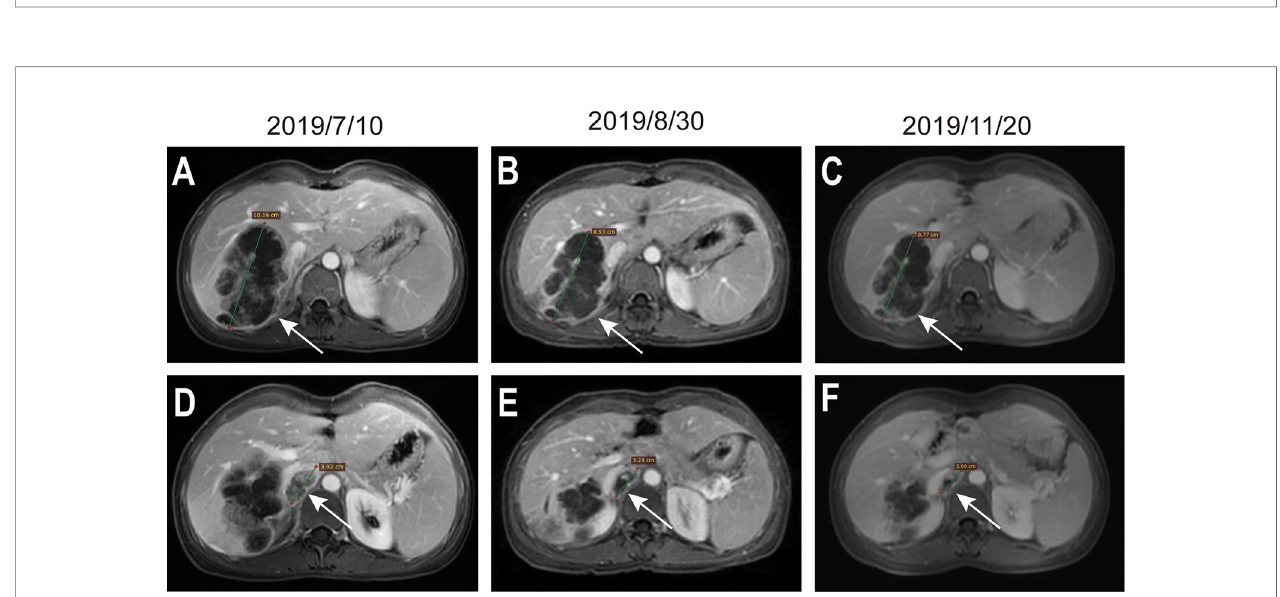
FIGURE 3 | MRI evaluation during preoperative systemic treatment. (A – C) indicate the maximum diameter of the lesion located in the liver, the maximum diameter of the lesion in (A – C) were 10.16cm, 8.93cm, and 8.77cm. (D – F) indicate the lesion located in the tumorigenic thrombus of the inferior vena cava, the maximum diameter of the lesion in (D – F) were 3.92cm, 3.28cm, and 3.00cm. Arrows in the fi gures indicate the position of